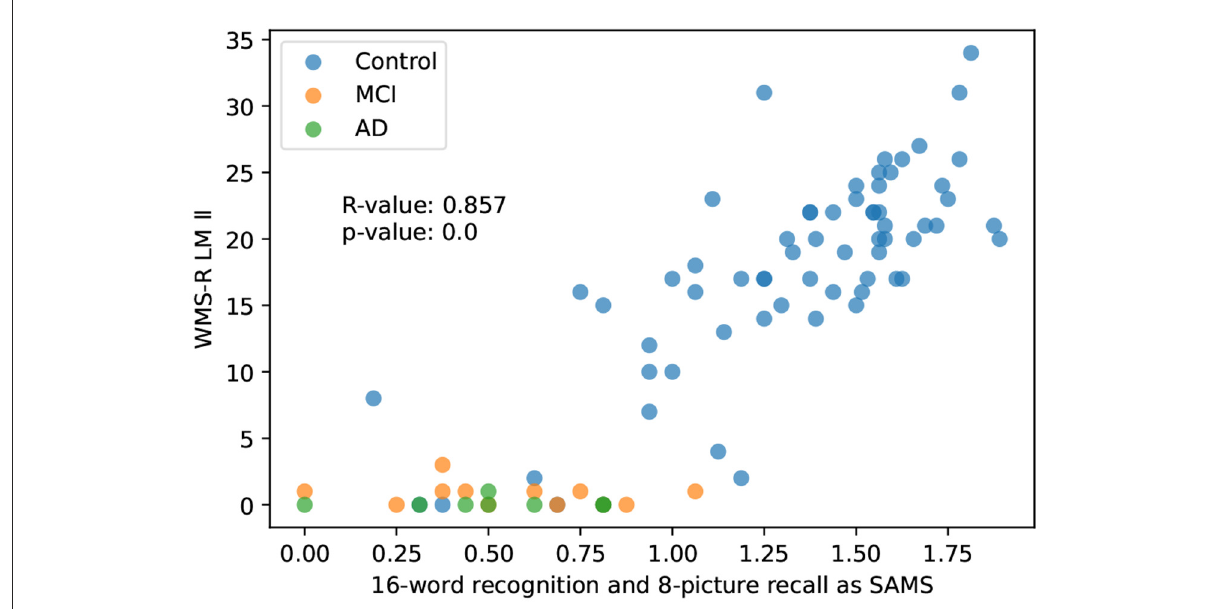
FIGURE5 The correlation between the set of the two tasks and the WMS-R delayed